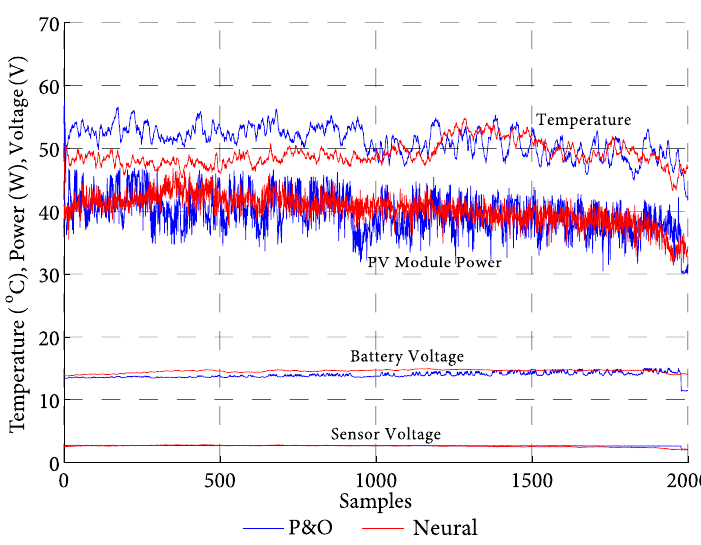
Figure 23. Real system duty cycle.